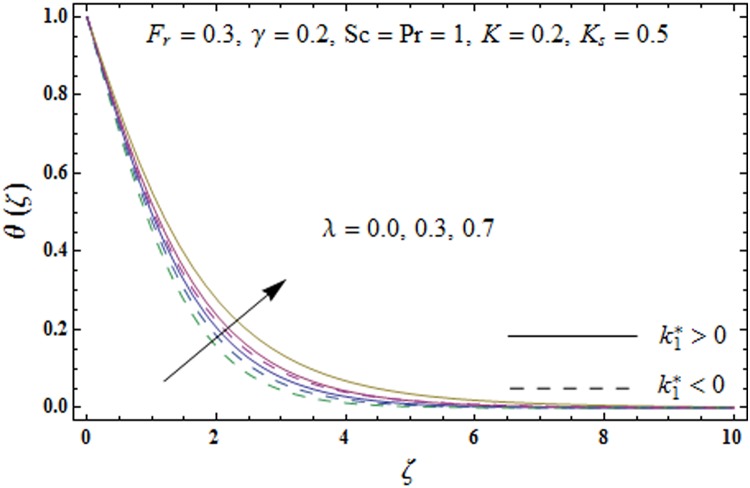
Plots of temperature field θ(ζ) for porosity parameter λ.